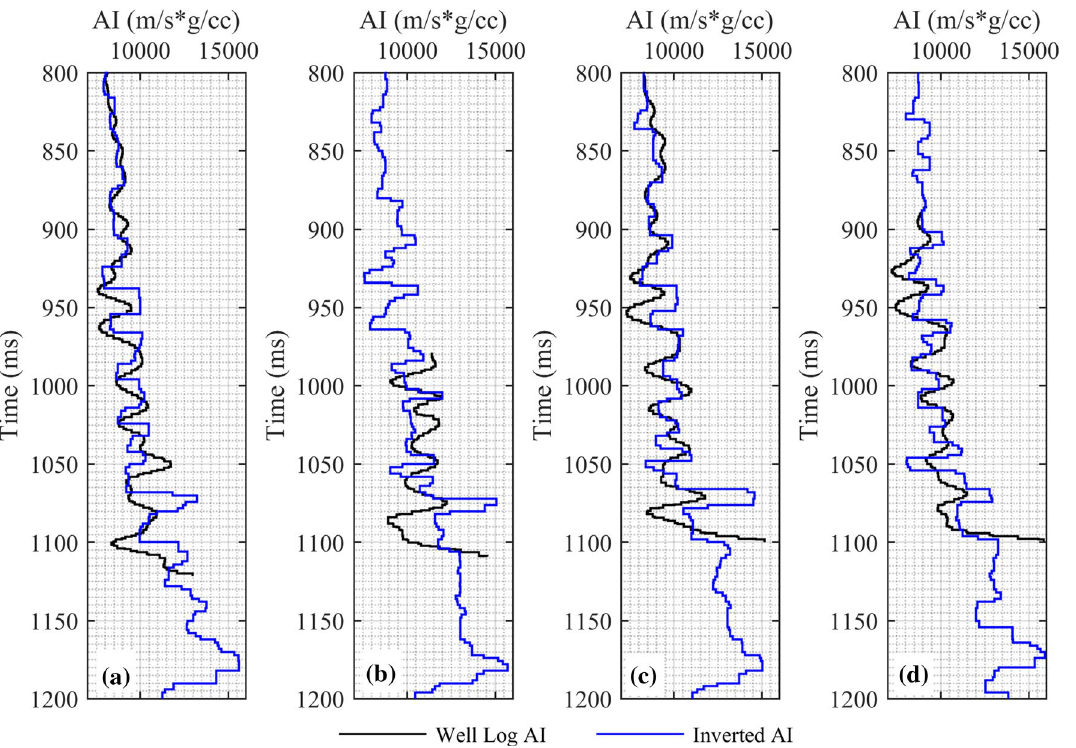
Fig. 4 Comparison of inverted acoustic impedance (red) with the actual impedance (black) for the a well 01–17, b well 08–08, c well 16–08, and d well 12–16